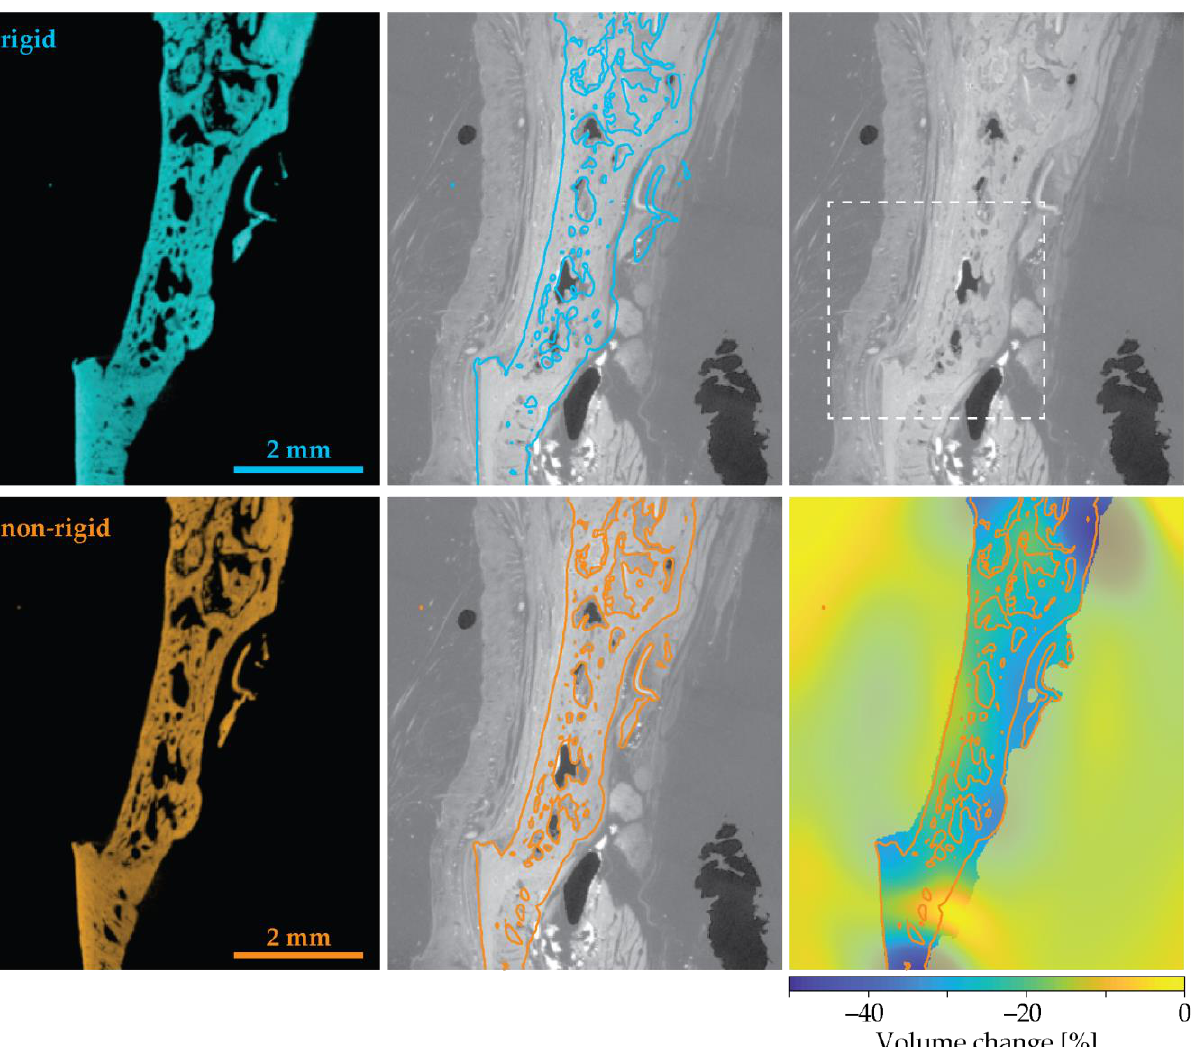
Figure 5. A selected virtual cut through the tomography data indicates registration quality. Rigid registration displayed in the first row does not provide a reasonable alignment between ( left ) non- decalcified bone and ( right ) decalcified tissue. The employed non-rigid registration enabled the quantification of local shrinkage, represented by the color bar ( bottom right ). The dashed-line box marks the region cropped for the data in Figure 6.